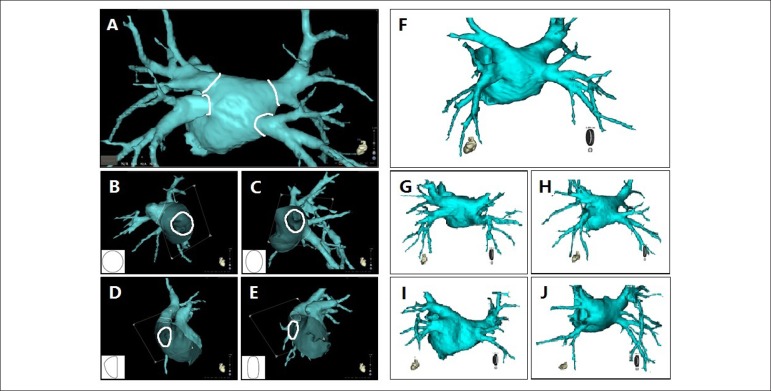
PV ostium shapes category and PV drainage patterns. A) PV ostia
depicted semi-automatically using CartoMerge software. Four shapes
of PV ostium; B) Type I (round); C) Type II (oval); D) Type III
(triangular); and E) Type IV (narrow). Five patterns of PV drainage;
F) Four PVs drains into LA in a typical pattern; G) Left superior
and inferior PVs drains into LA both in a pattern of with common
trunk; H) Left superior and inferior PVs drains into LA both in a
pattern of with common antrum; I) Right inferior PV drains into LA
in a pattern of with ostial branch; J) Right superior and inferior
PVs drains in LA with supernumerary vein (middle vein).